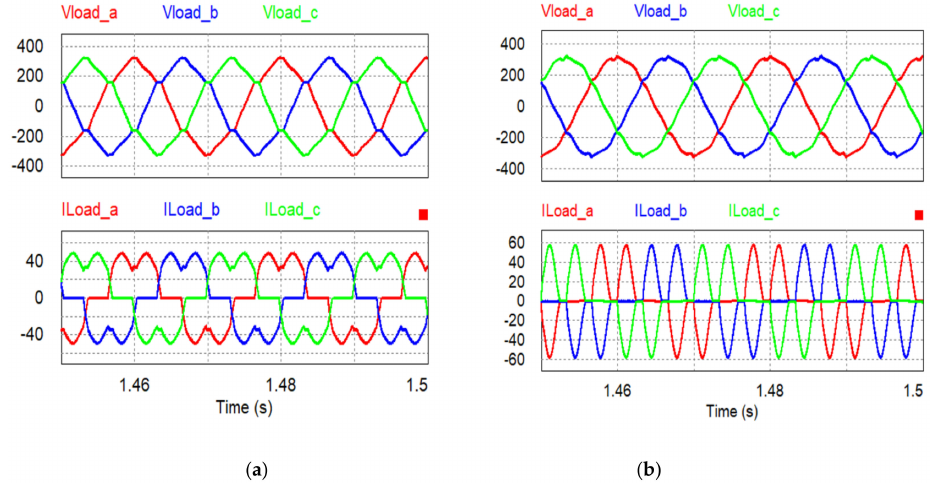
Figure 22. Simulation result of resonant controller under a nonlinear load. ( a ) Conventional controller; ( b ) Resonant